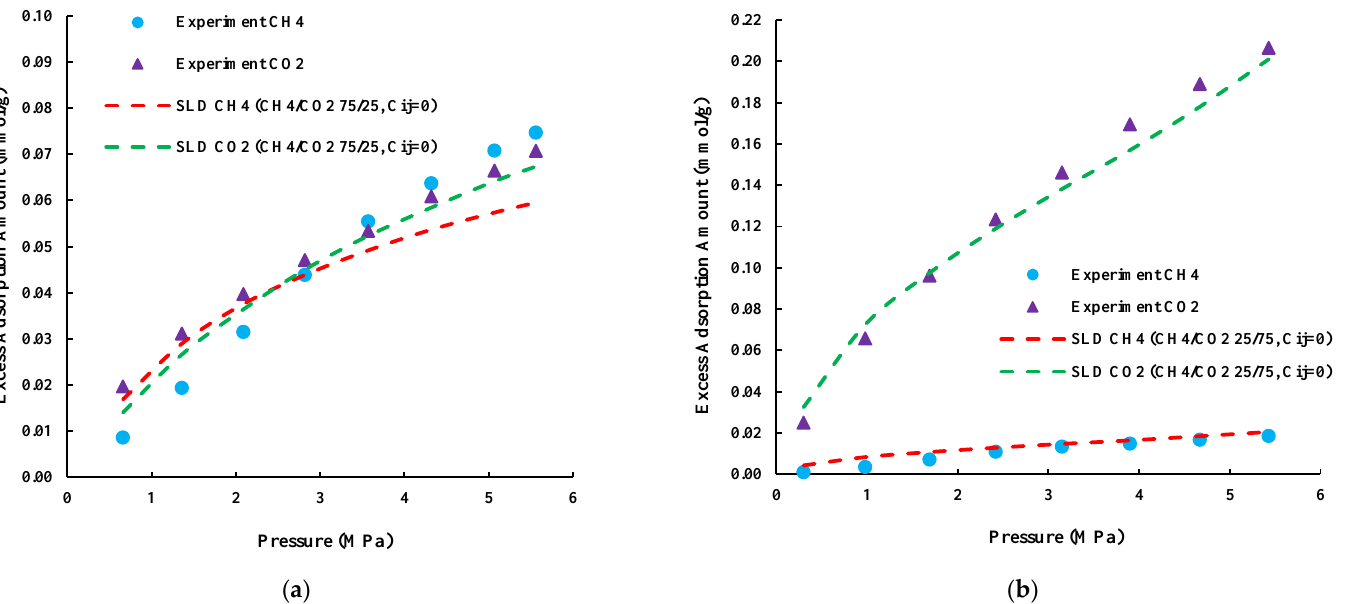
Figure 3. Excess adsorption isotherms of each component in 75/25 and 25/75 CH 4 /CO 2 mixtures in shale at 313.15 K. ( a ) Gas mixture (CH 4 /CO 2 75/25). ( b ) Gas mixture (CH 4 /CO 2 25/75).